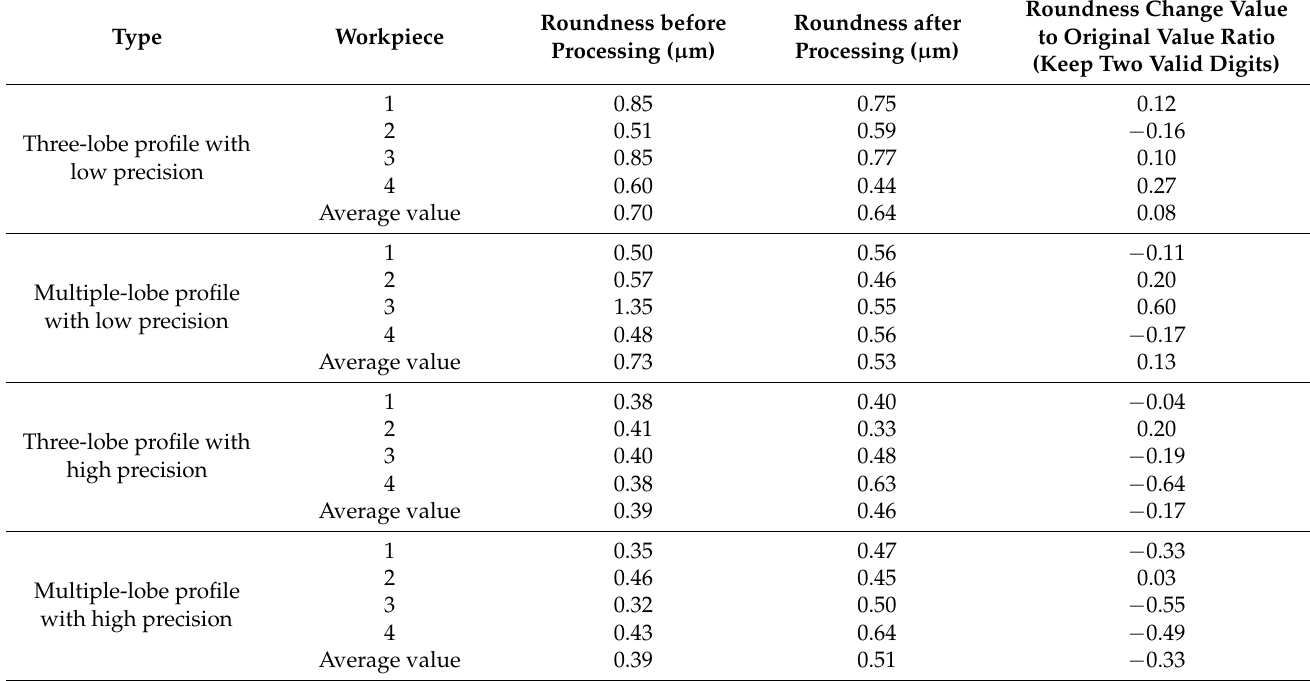
Table 8. Experimental results with 30° cathode coverage.